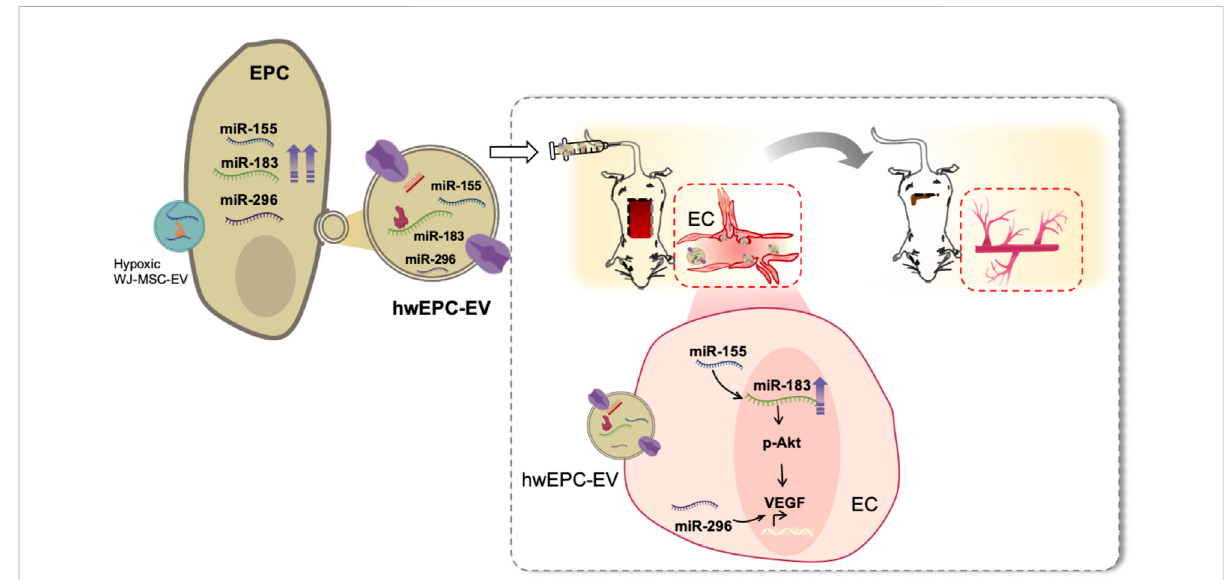
FIGURE 5 hwEPC-EV is a promising candidate to treat ischemic injuries of the distal organs and tissues. hwEPC-EV is preferentially uptaken at the ischemic tissues of the fl ap mouse model in the intravenous injection. At the ischemic sites, hwEPC-EV induced the proliferation and angiogenic functions of ECs which might be involved in the transfer of miRNAs related to angiogenesis, including miR-155, miR-183, and miR-296 to EC. Therefore, the intravenous injection of hwEPC-EV resulted in the recovery of the ischemic